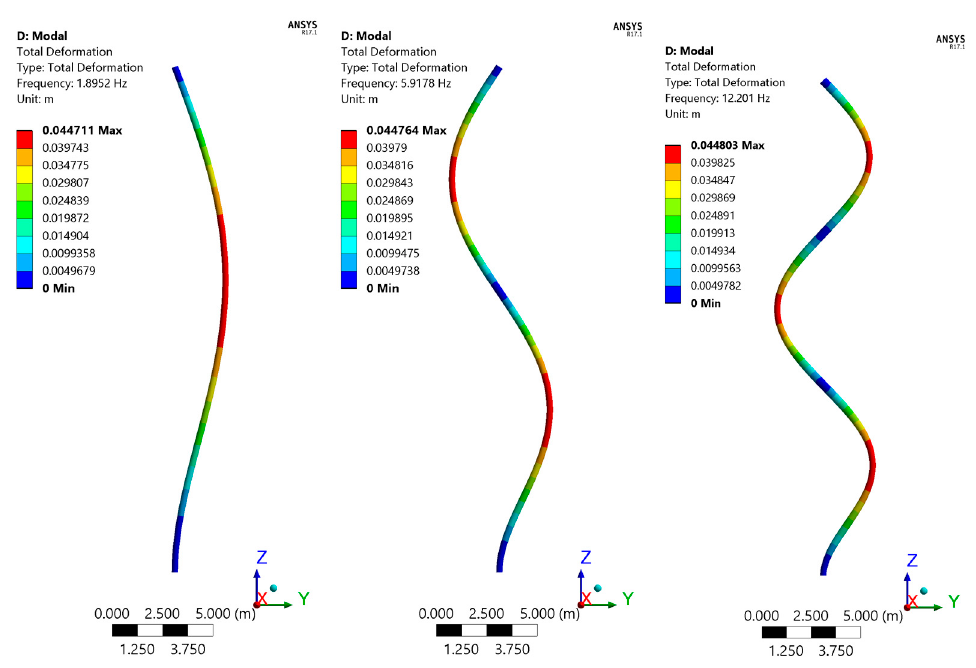
Figure 5. First three mode shapes of fiber reinforced polymer (FRP) composite riser 3.